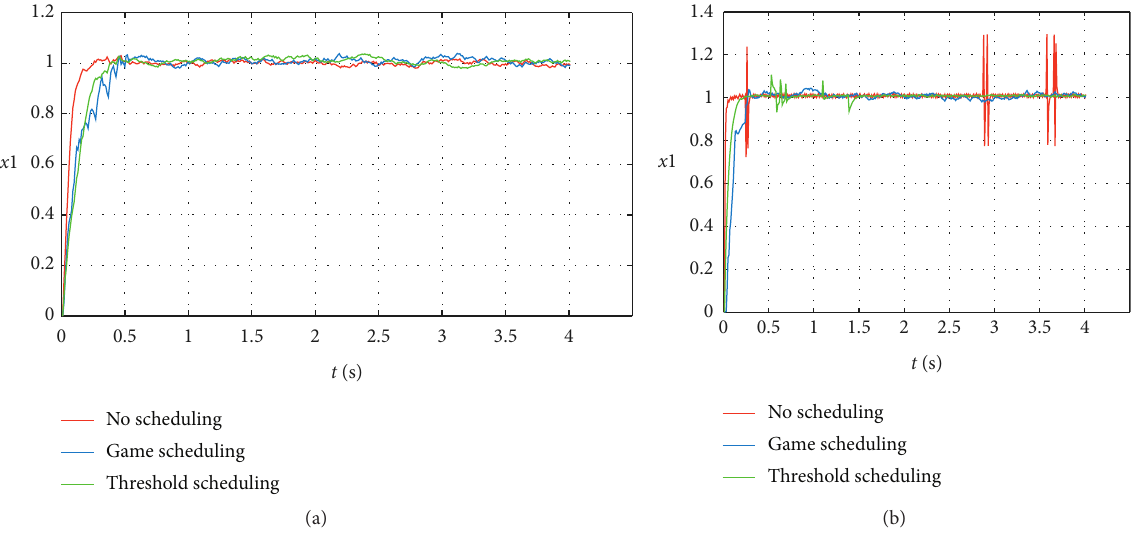
Figure 8: Step response under different scheduling strategies with interference. (a) 10% band interference; (b) 60% band